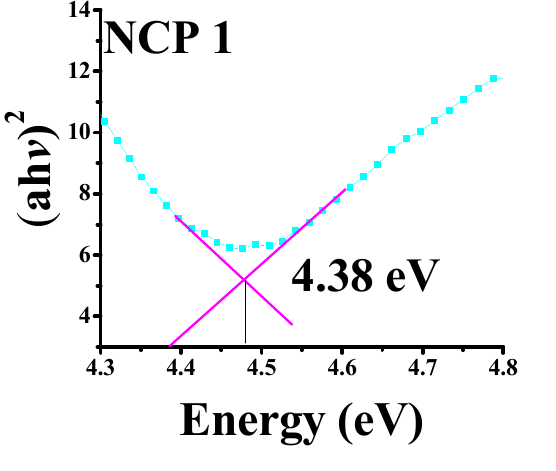
Figure 6. Transmittance of the composites. The bandgap energies were calculated by plotting the absorbance coefficient ((ahv) 2 ) versus the energy (hv), as shown in Figure 7.